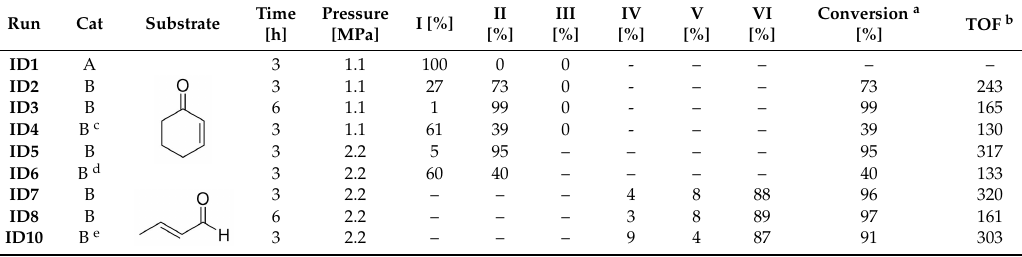
Table 1. Catalytic performances of Pt(Bipy)Cl 2 (A) and Pt(PLLA-Bipy)Cl 2 (B) in the selective hydrogenation of 2-cyclohexen-1-one (I) and (E)-but-2-enal (IV) at 60 ◦ C.